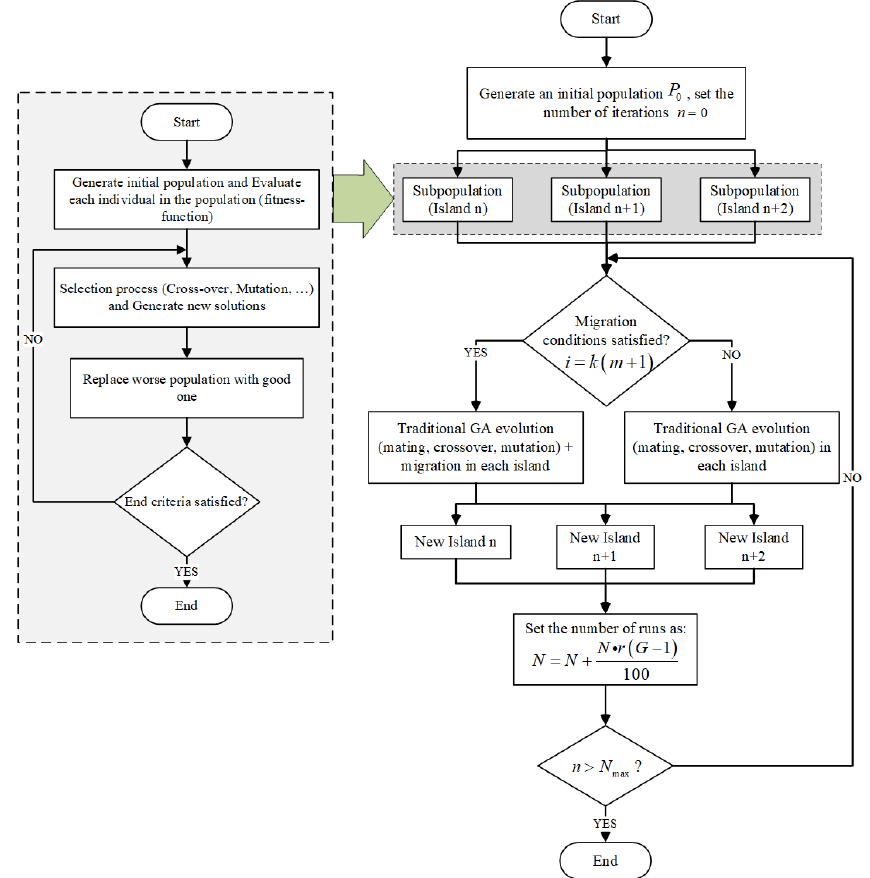
Figure 3. MIGA optimization process.